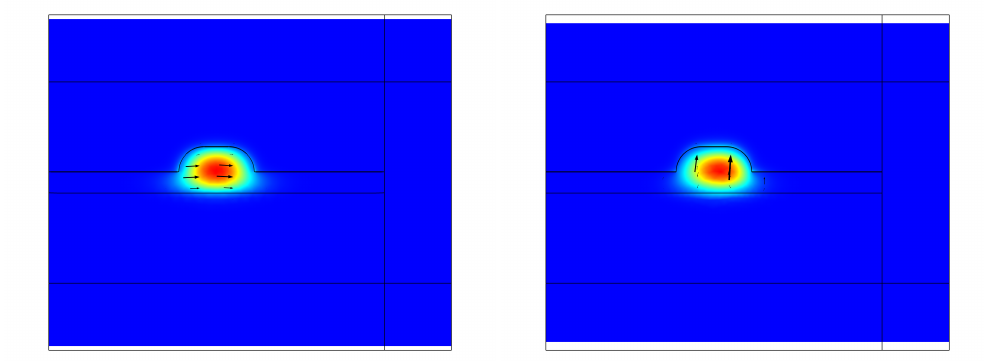
Figure 5. TE and TM modes profiles in a bent waveguide at a bending radius of 9 µ m.